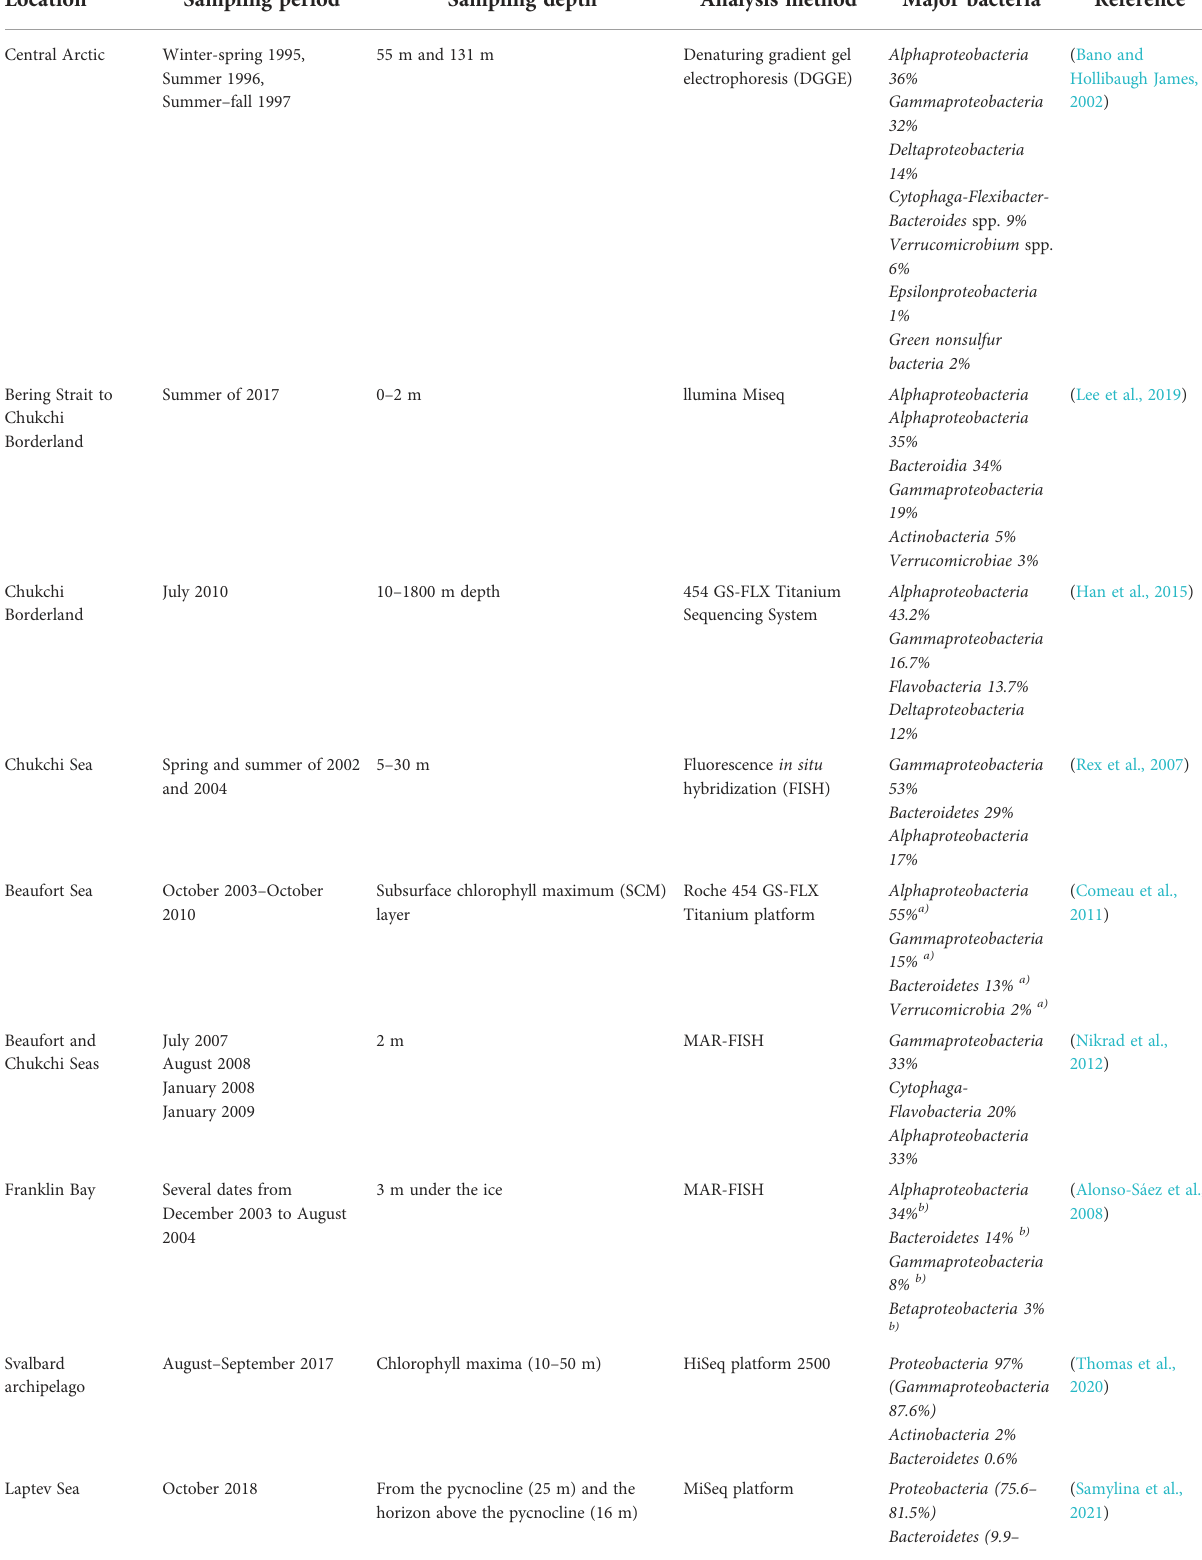
TABLE 3 Composition of bacteria in sea waters summarized from previous studies in the Arctic